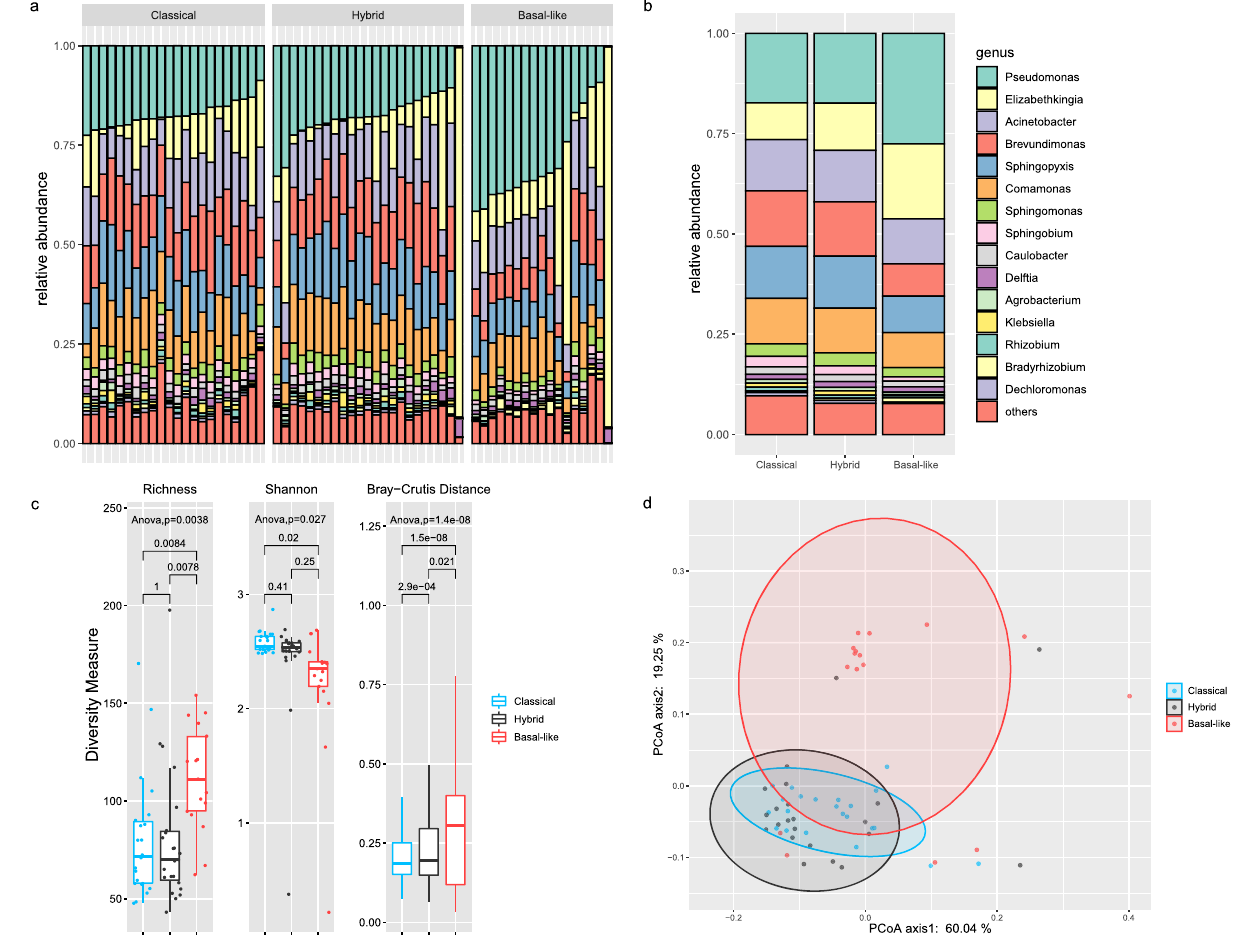
Fig. 2 The tumor microbiome shows signi fi cant differences among PDAC subtypes. a – b Barplots denote the relative abundance of predominant microbiota constituents at the genus level for each sample ( a ) and for each subtype ( b ). c Boxplots of microbial diversity measures at the genus level, including richness (observed genera), Shannon index and Bray-Curtis metric distance. P values were determined by ANOVA with post-hoc test. d PCoA plot of the tumor microbiome at the genus level based on Bray – Curtis dissimilarity. The ellipses indicate the 90% con fi dence